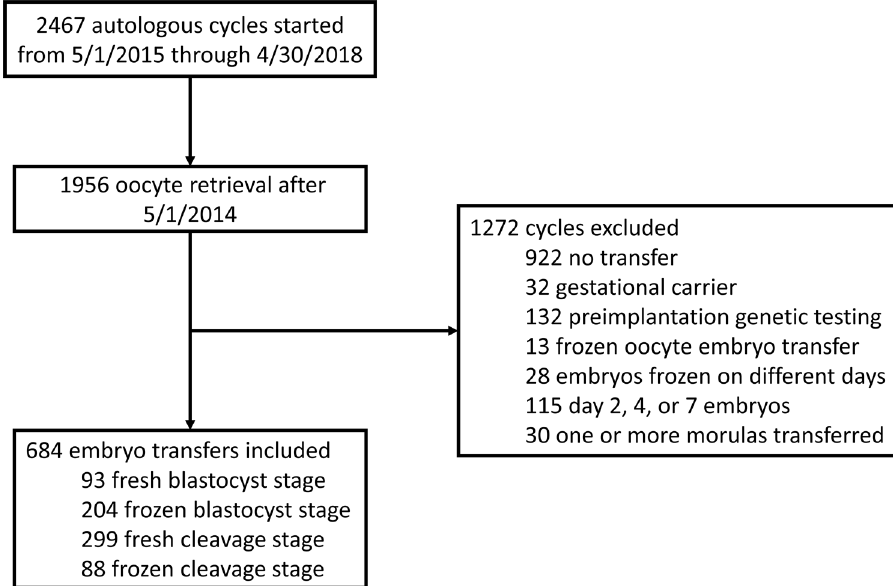
Figure 1. Embryo transfer cycles included and